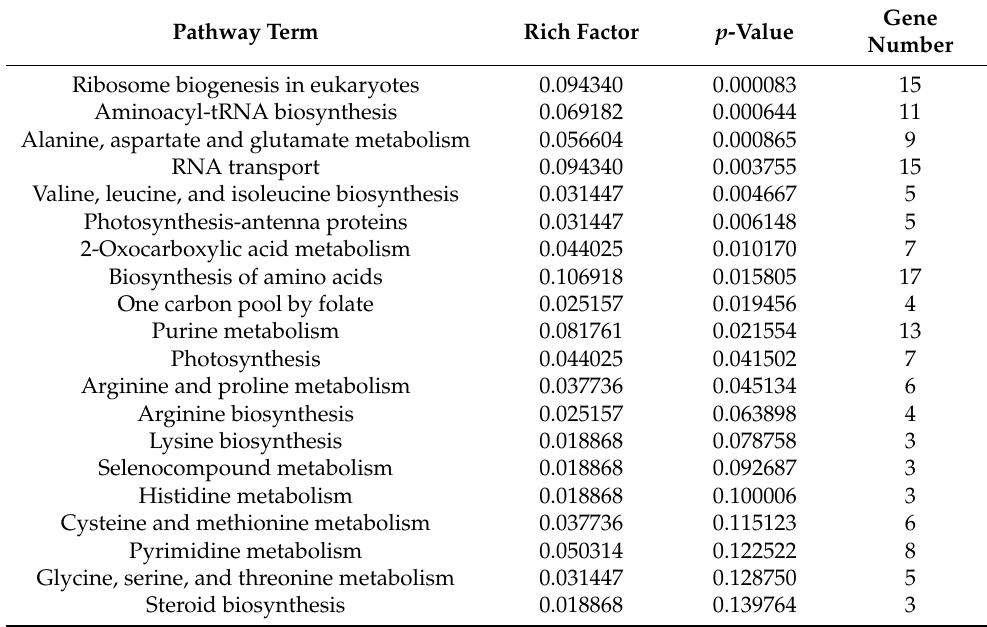
Table 3. The upregulated pathways of differentially expressed genes significantly enriched in KEGG in the 3.6 g/L CaCl 2 group compared with the 0.036 g/L